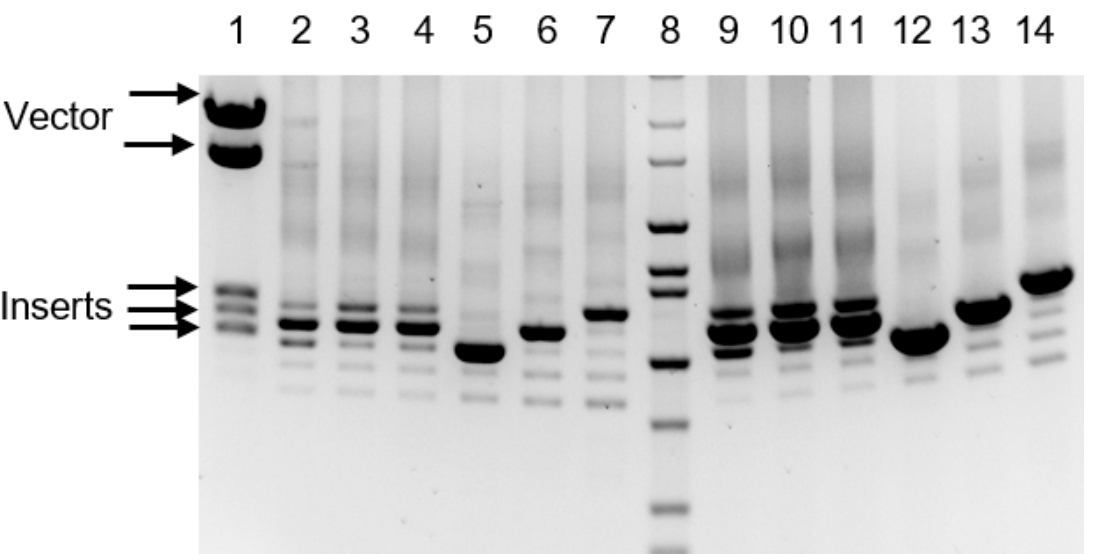
Figure 1. Analysis of the tandem repeats in COS-7 mitochondrial DNA (mtDNA). Lane 1: The three longest PCR products were cloned in the plasmid pBluescriptII SK+; the resulting recombinant plasmids were mixed and digested with restriction endonucleases flanking the site of insertion to release cloned fragments. Lanes 2–4: genomic DNA from the COS TS 1, COS-7 and the CV1 cell lines, respectively, amplified with primers agmF33 and agmR_1 with Platinum Superfi DNA polymerase. Lanes 9–11: the same samples amplified with GoTaqG2. Lanes 5–7: DNA from 143B ρ 0 cells was spiked with plasmids containing PCR fragments with three, four or five 108 bp repeats, respectively, and amplified as in lanes 2–4. Lanes 12–14: DNA samples as in lanes 5–7 amplified with GoTaqG2. Lane 8, HiLo DNA ladder.